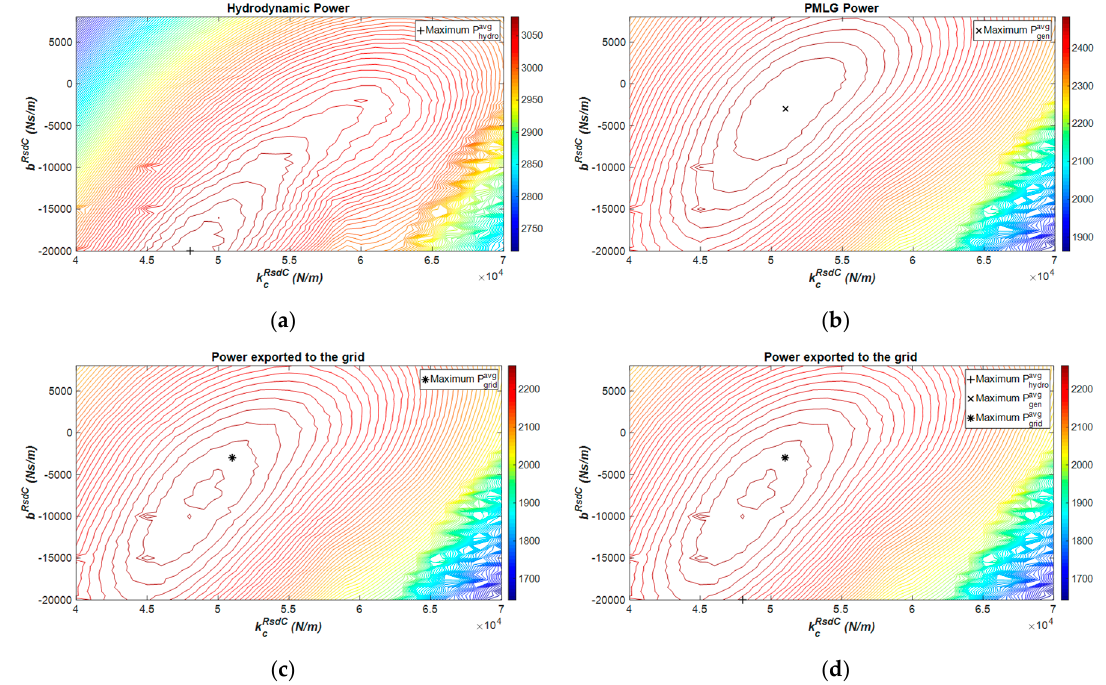
Figure 11. Grid search optimization of (cid:1854) (cid:1844)(cid:1871)(cid:1856)(cid:1829) and (cid:1863) (cid:1855)(cid:1844)(cid:1871)(cid:1856)(cid:1829) to maximize: ( a ) Hydrodynamic power ( b ) PMLG power P avg gen ; ( c ) Power exported to the grid P avg ; ( d ) Power exported to the grid with grid (cid:1842) (cid:3035)(cid:3052)(cid:3031)(cid:3045)(cid:3042)(cid:3028)(cid:3049)(cid:3034) ; ( b ) PMLG power (cid:1842) (cid:3034)(cid:3032)(cid:3041)(cid:3028)(cid:3049)(cid:3034) ; ( c ) Power exported to the grid (cid:1842) (cid:3034)(cid:3045)(cid:3036)(cid:3031)(cid:3028)(cid:3049)(cid:3034) ; ( d ) Power exported to the grid overlapped peak power points of hydrodynamic and PMLG with overlapped peak power points of hydrodynamic and PMLG output.